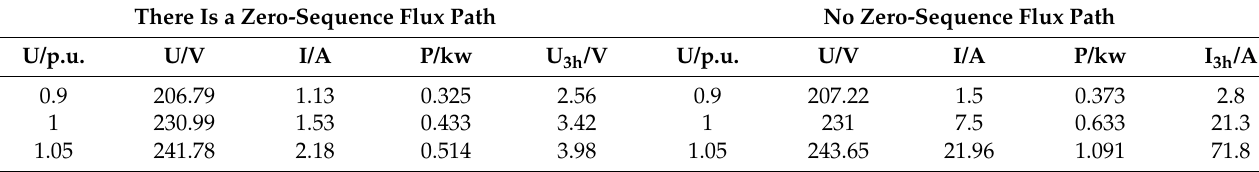
Figure 15. Variation trend of frame flux harmonic content. 5. Conclusions Frame-magnetic-flux of the positive-sequence, negative-sequence component is de- rived from the magnetic flux, and all of 3/1 phase flux amplitude. The positive-se- quence component of harmonic, frame flux lag phase flux 30, harmonic and negative-se- quence component points frame flux 30° phase flux in advance. The zero sequence com- ponent is not included in the phase flux harmonics, and the points frame contained in the magnetic flux harmonic and the higher magnetic circuit working point of the zero se- quence component contains three times more harmonic. In a certain sense, the frequency conversion function is realized. Then, the effectiveness of the proposed scheme is con- firmed through the simulation of finite element simulation software and experimental verification. Author Contributions: Writing—original draft preparation, Z.S.; Project administration, L.L.; Writ- ing—review and editing, J.L., Z.L., H.L. and P.Z. All authors have read and agreed to the published version of the manuscript. Funding: This research received no external funding. Institutional Review Board Statement: Not applicable. Acknowledgments: This research was supported by the Hunan youth talent project of China (2020RC3102). Conflicts of Interest: The authors declare no conflict of interest. References